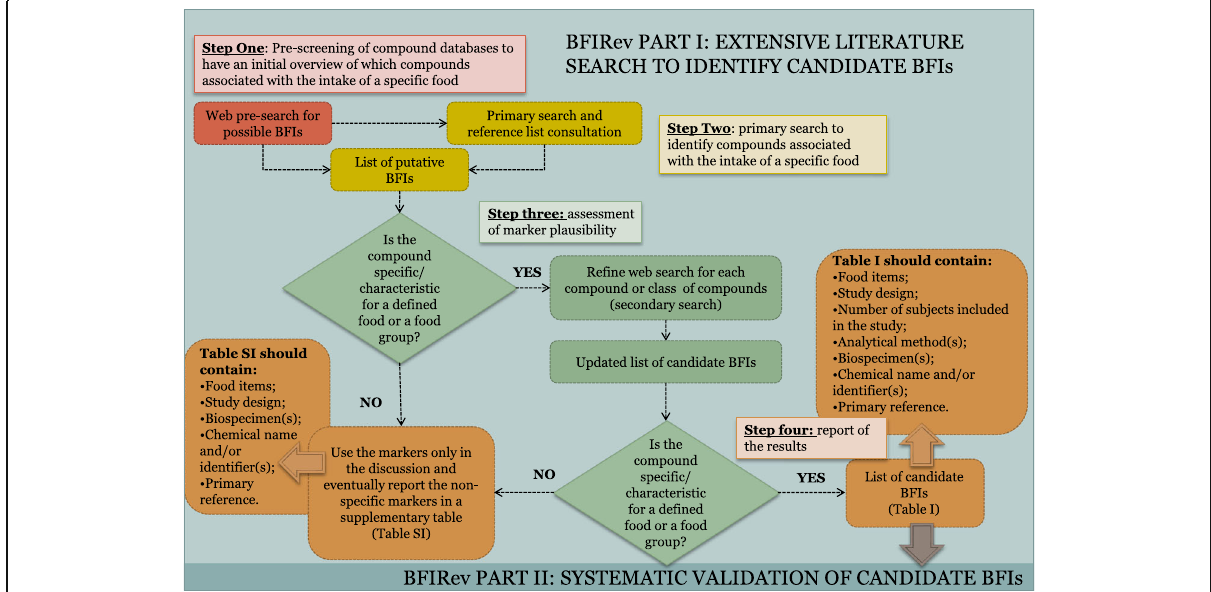
Fig. 1 Scheme of the currently suggested BFIRev research methodology. The “ Guidelines for Biomarker of Food Intake Reviews (BFIRev) ” 4-step procedure is designed for listing candidate food or food group biomarkers (Table I) while also retrieving important information for biomarker validation, whenever it is available. BFIRev is shown here as a decision tree listing the most important steps. The questions in the diamonds should be assessed by at least two researchers